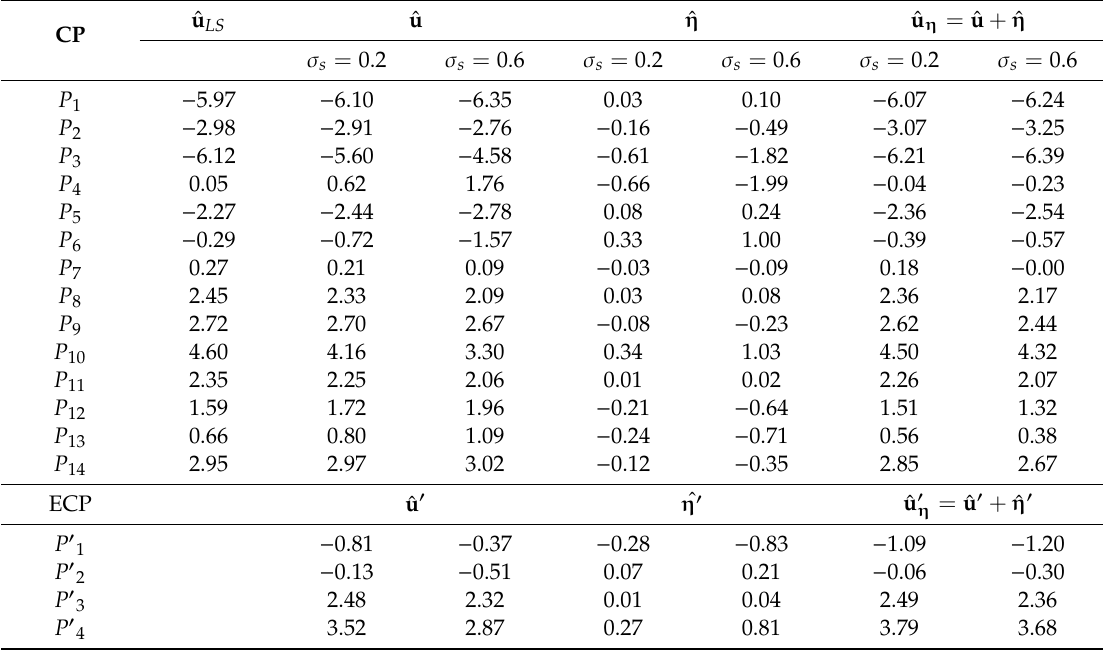
Figure 9. The courses of norms values in the iterative process: ( a ) random displacement ( b ) surface noise. Table 4. The results of estimation and prediction for the real FCN (in